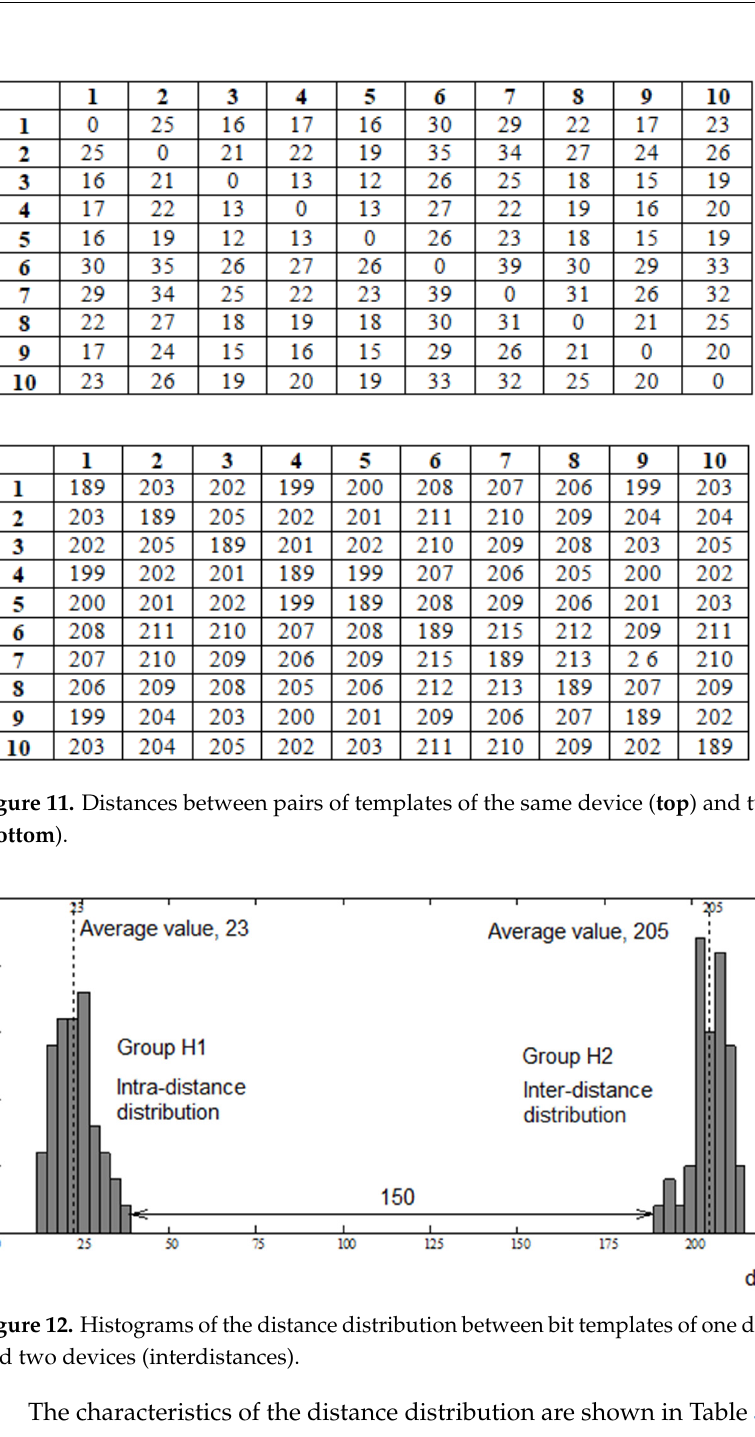
Table 5. The characteristics of the distance